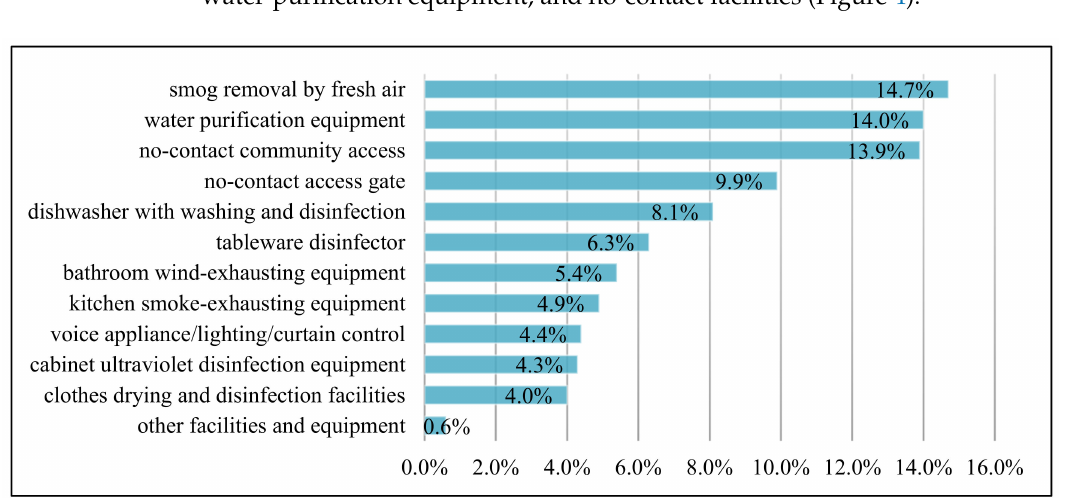
Figure 4. Residents’ major concerns in the future.